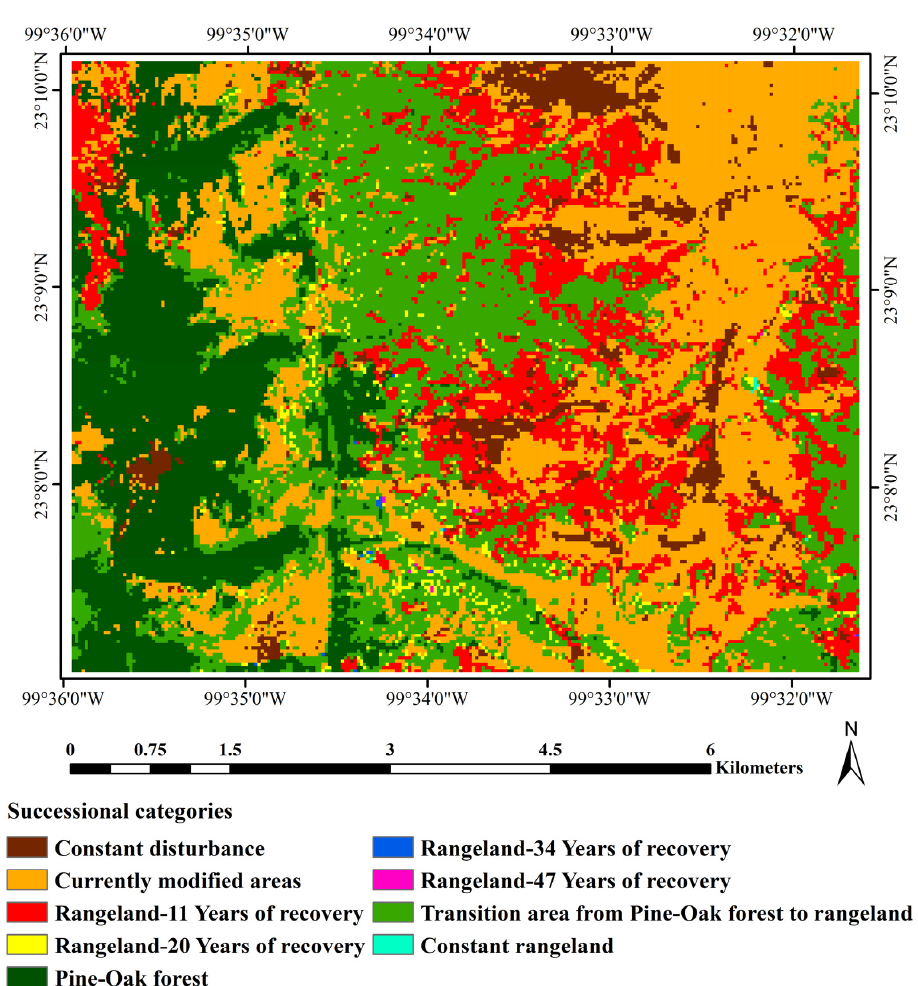
Figure 17. Represented area (km 2 ) for each category of land use coverage during the study period, San Vicente, Palmillas, Tamaulipas, Mexico.